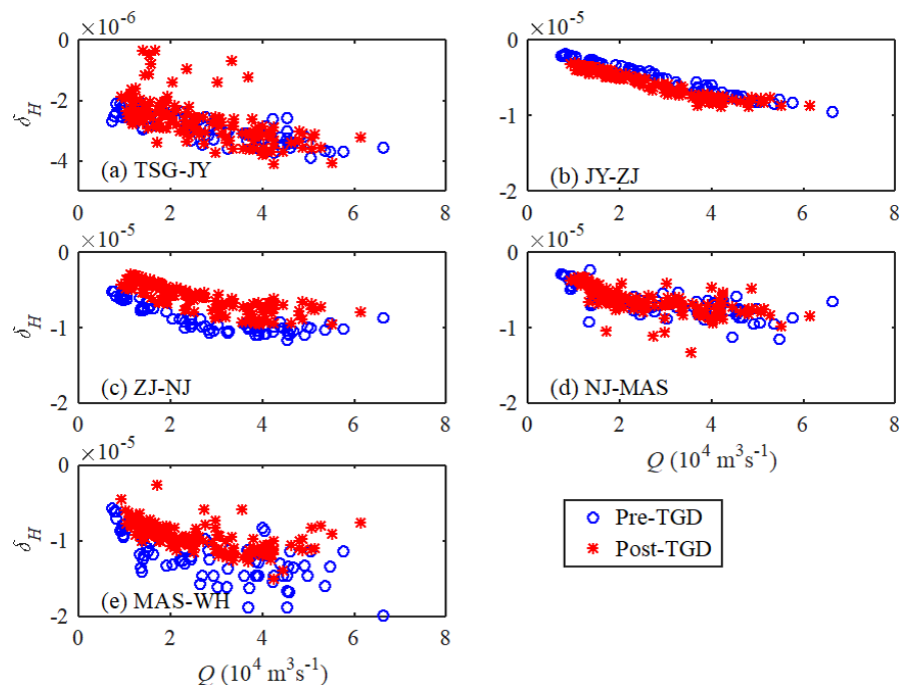
Figure 3. Changes in tidal damping rate δ H before and after the TGD closure for different reaches along the Yangtze estuary: (a) TSG-JY,